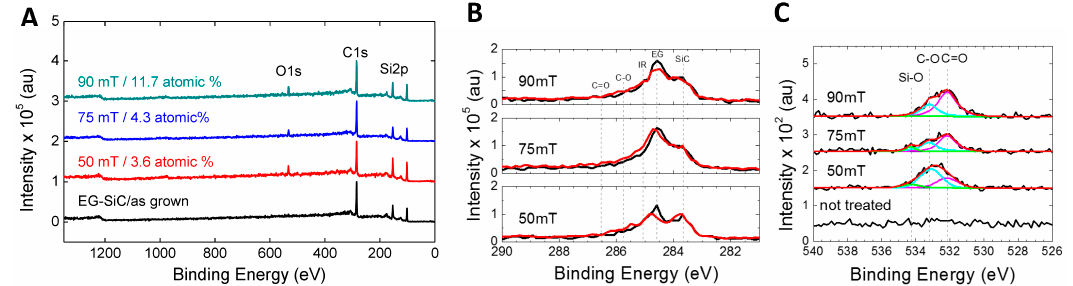
Figure 1. X-ray photoelectron spectroscopy (XPS) of unmodified, and oxygen modified graphene, depicting the ( A ) survey spectra; ( B ) the high resolution C1s spectra and ( C ) the high resolution O1s spectra. The black curve represents before functionalization, and red curve after functionalization in ( B ).